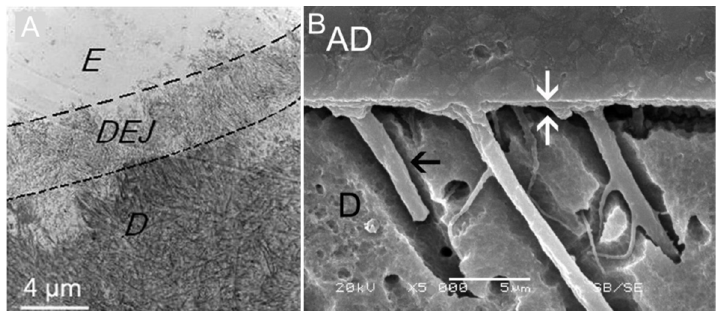
Figure 4. SEM microphotographic features of the dentinoenamel junction (DEJ); enamel (E); dentin (D); reused open access image from Niu et al. [146] ( A ). The resin–dentin interfaces with hybrid layers are indicated by white arrows; adhesive (AD); dentin (D); the black arrow indicates resin tags; reused open access image by Pomacóndor-Hernández et al. [147] ( B ).